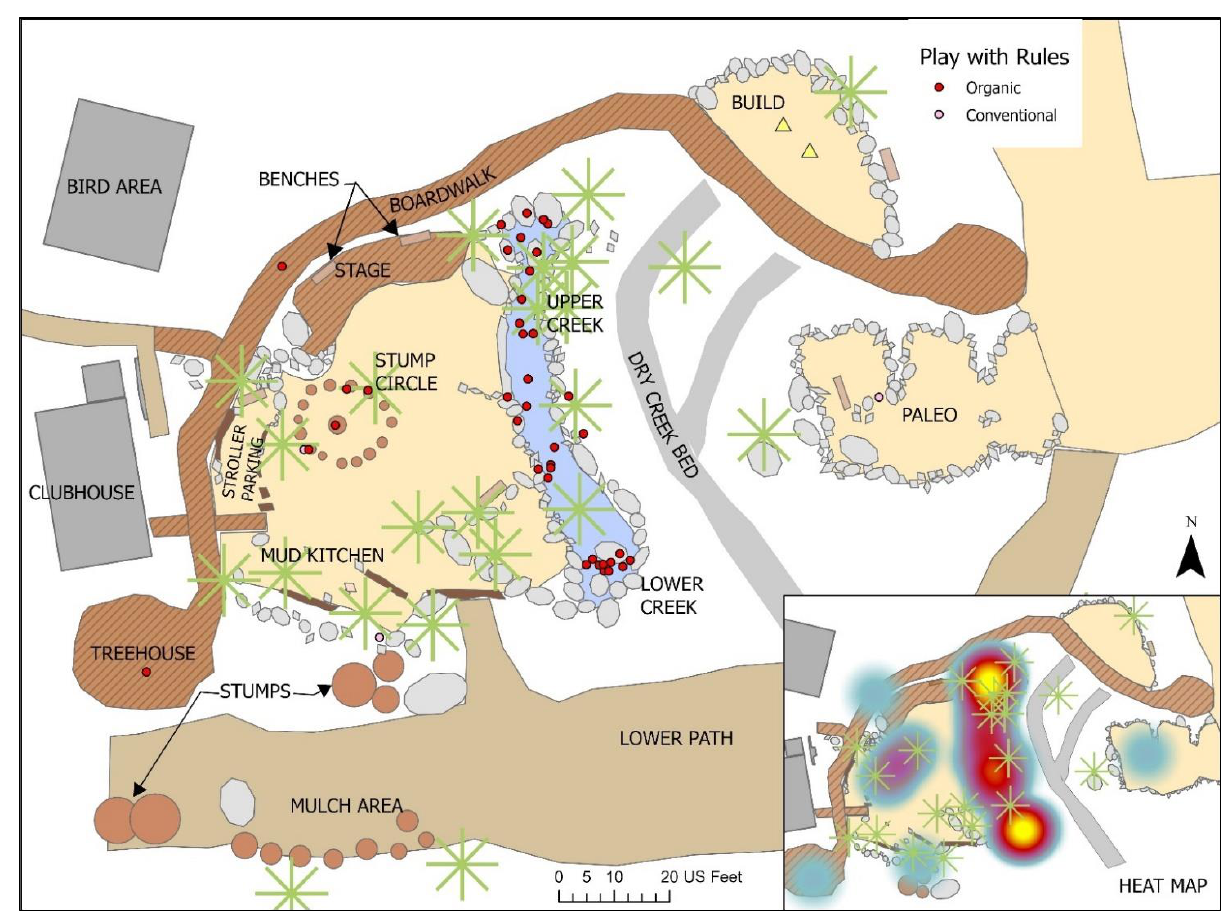
Figure 17. Behavior map of all Play with Rules activities.